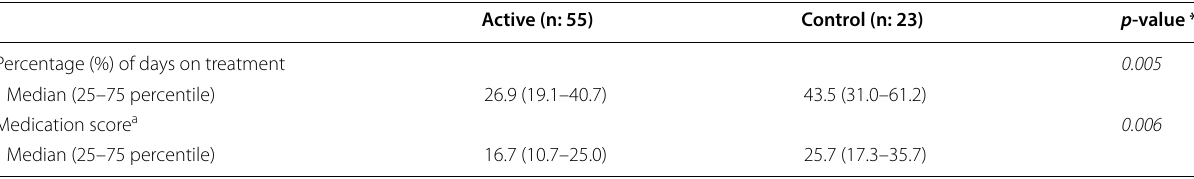
p -values < 0.05 are shown in italics a Medication score 0 – 100 depending on the drugs